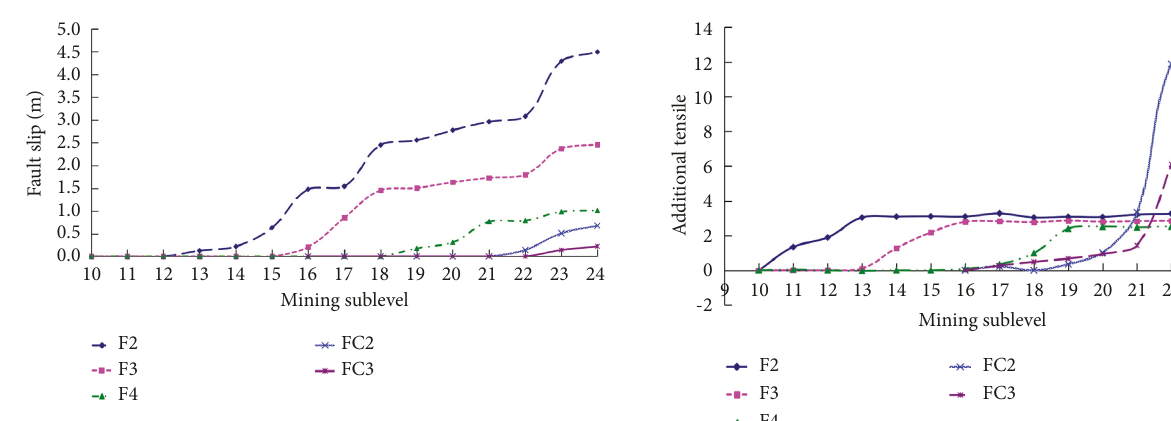
Figure 22: The time-space relationship curve of the slip amount of each fault with mining depth.